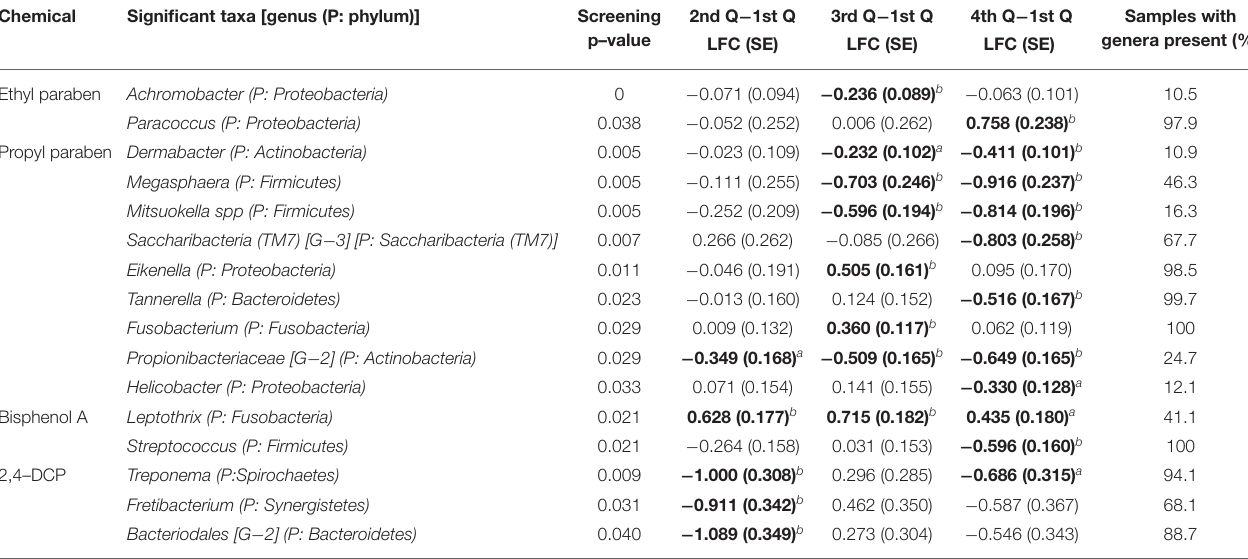
TABLE 4 | Pairwise test comparing the corresponding group with the reference group (1st quartile) of urine chemical biomarker exposure and bacterial genera.